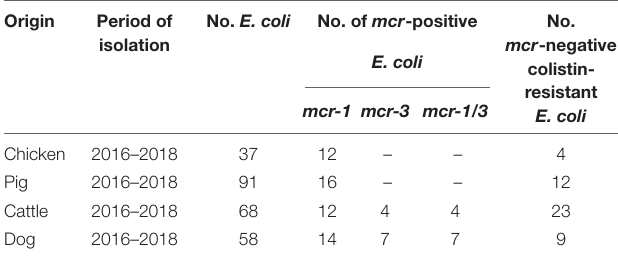
Table 4 . The obtained DNA sequence alignments were